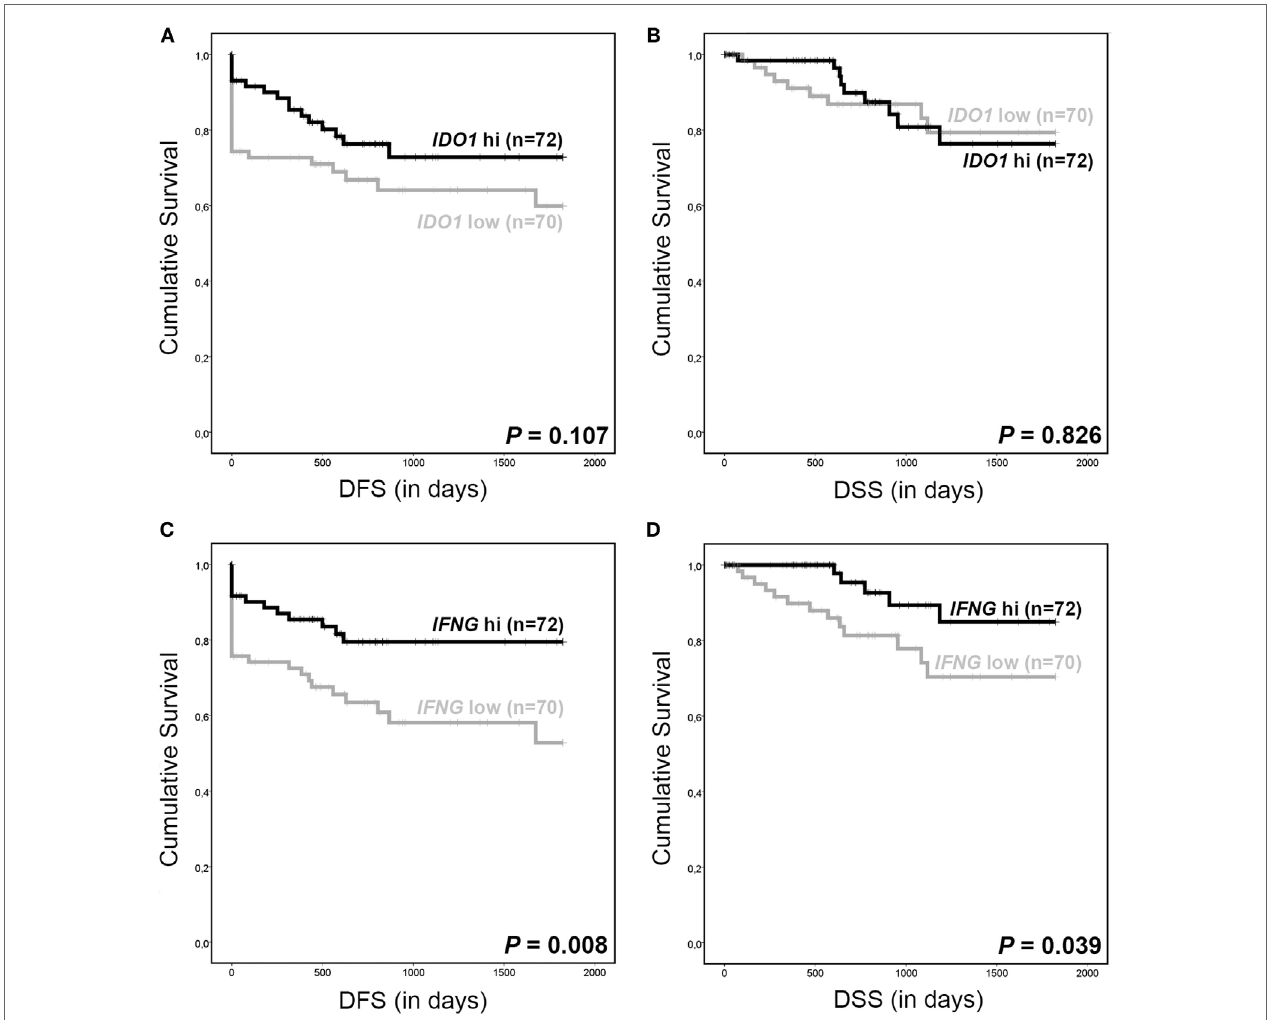
FigUre 7 | IDO1 and IFNG RNAseq data from The Cancer Genome Atlas. Kaplan–Meier 5-year survival curve shows (a) disease-free survival (DFS) and (b) disease-specific survival (DSS) for patients with low (gray line, median as cutoff, < 9.92) and high (black line, median as cutoff, ≥ 9.92) IDO1 mRNA expression. Kaplan–Meier 5-year survival curve shows (c) DFS and (D) DSS for patients with low (gray line, median as cutoff, < 3.71) and high (black line, median as cutoff, ≥ 3.71) IFNG mRNA expression. NB: survival data were missing for two patients. P values for survival analysis were calculated using the log-rank